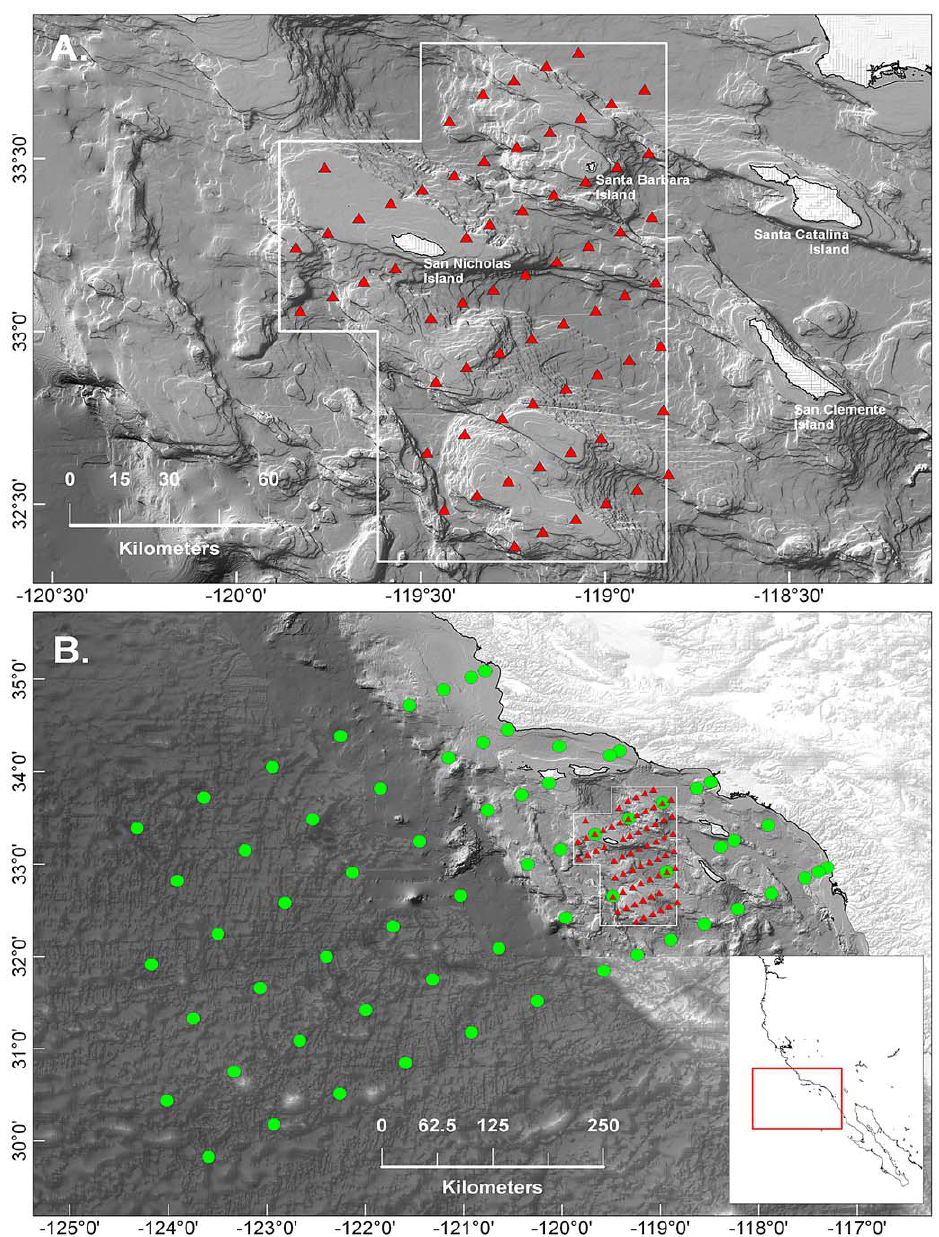
Figure 1. Maps showing the multi-scale sampling domains and locations where samples were collected. (A) Cowcod Conservation Area (CCA) sampling domain. Triangles depict sample sites, and the white line delineates the border of the western CCA. (B) CalCOFI sampling domain. Circles indicate the location of CalCOFI sample sites, triangles the location of CCA sample sites, and white lines the borders of the western and eastern CCAs. The red rectangle in the inset figure delineates the geographic boundary of the area in (B) relative to a broader view of western North America.